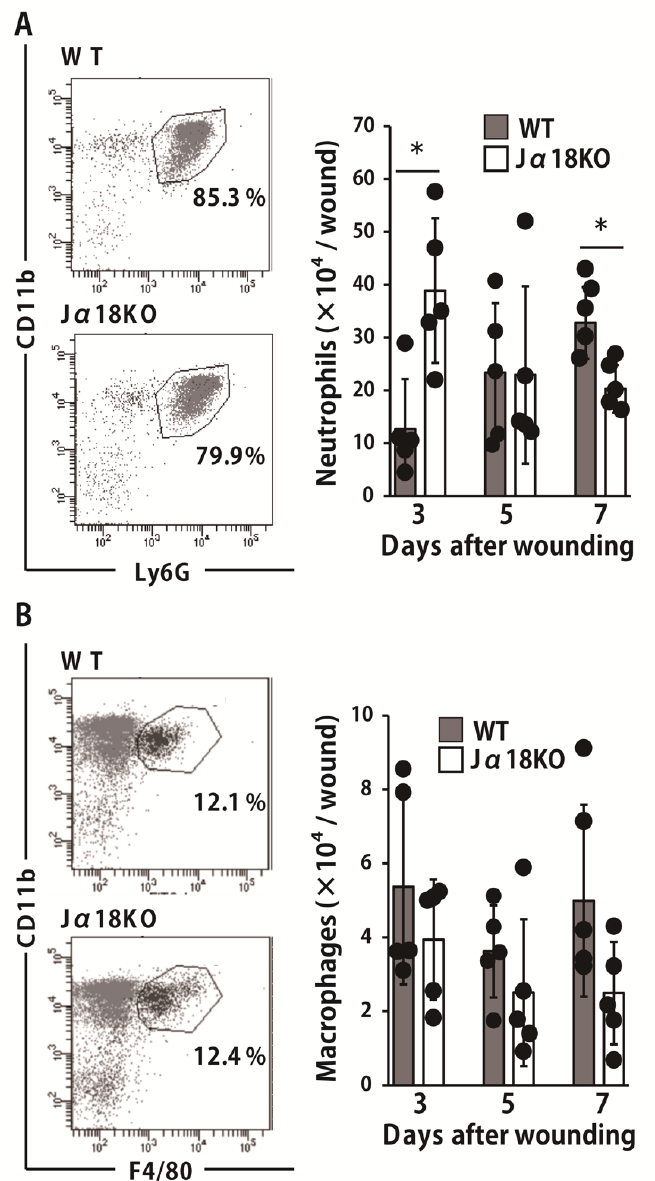
Figure 2. Effect of iNKT cell deficiency on neutrophils and macrophages migration at the wound sites after inoculation with P. aeruginosa . Wounds were created on the backs of WT or J α 18KO mice, and P. aeruginosa was directly inoculated at the wound sites after wounding. Leukocytes were prepared from wounds at the indicated time points, and the number of neutrophils, defined as CD45 + Ly6G + CD11b + cells ( A ), and the number of macrophages, defined as CD45 + CD11b + F4/80 + cells was analyzed ( B ). Representative dot plots on day 7 are shown ( A , B ). Black circles represent one individual mouse. Each column represents the means ± SD ( n = 4–5). The results are representative of at least two independent experiments. * p < 0.05.